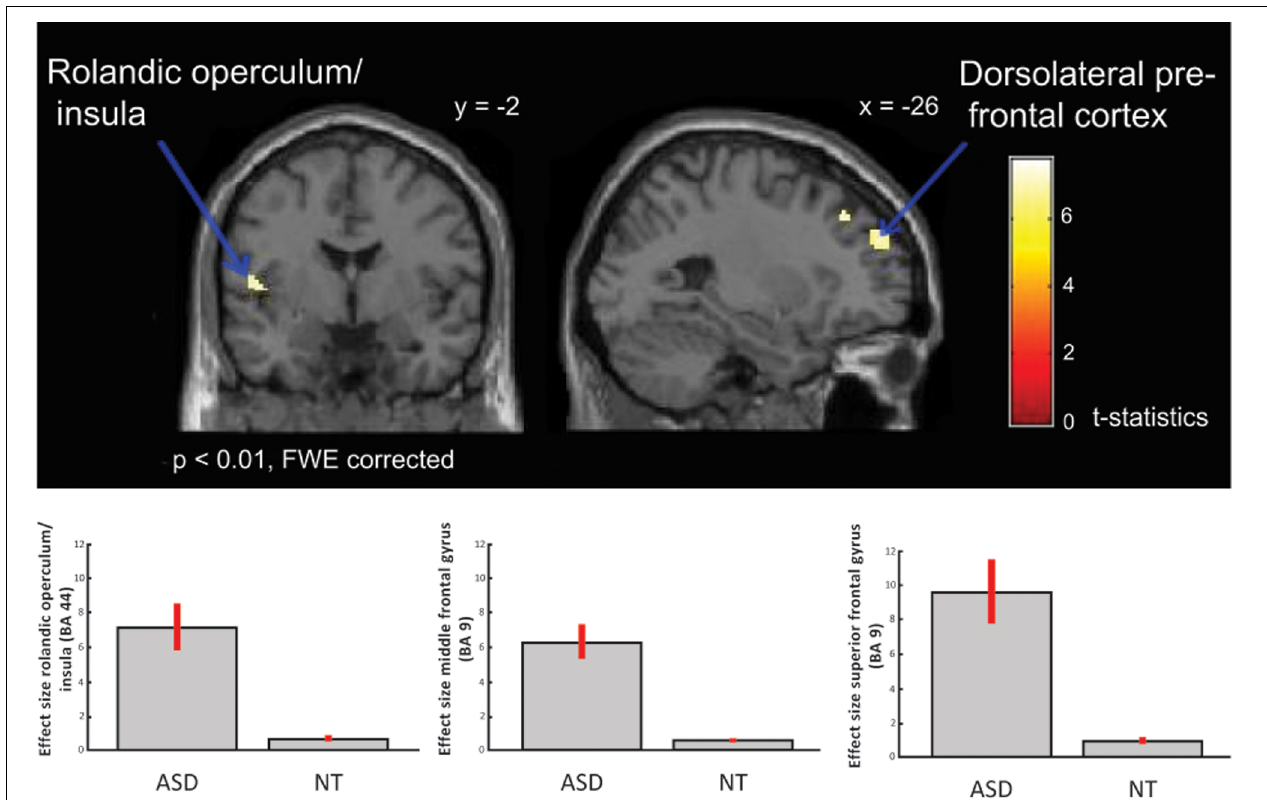
FIGURE 3 | ASD > NT: group difference for happy vs. sad music (FWE p < 0.01). Individuals with ASD showed increased activation in dorsolateral prefrontal cortex, i.e., middle and superior frontal gyrus,